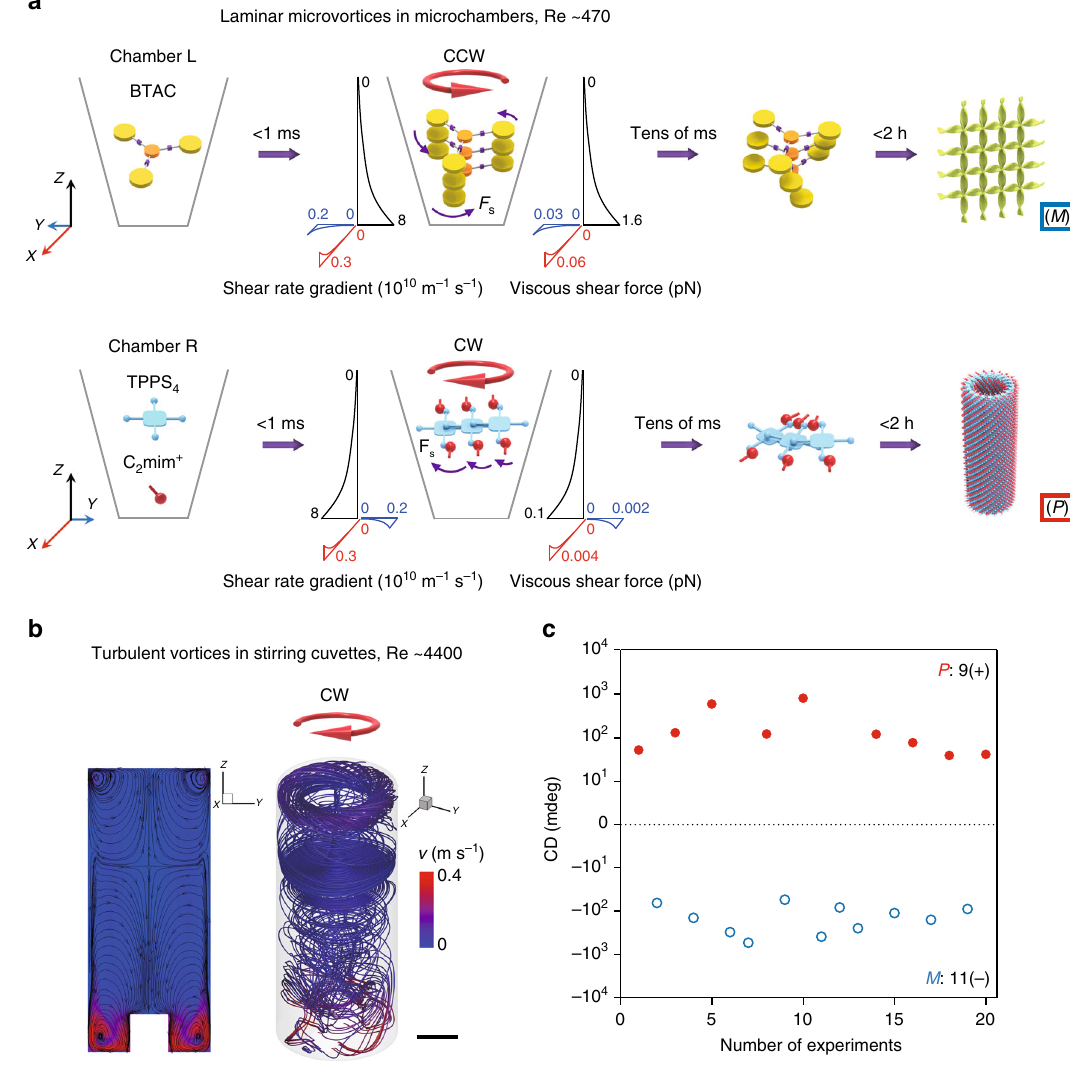
Fig. 5 Laminar chiral microvortices versus turbulent vortices in stirring cuvettes. a Schematic mechanism of laminar chiral microvortex-selected chirality of BTAC and TPPS 4 nuclei. The rapidly formed nuclei (<1 ms) are aligned in the laminar fl ow, and twisted by a shear force ( F s ) to give rise to an initial chiral bias dependent on the rotation sense of microvortices. These primary nuclei then serve as the templates for the subsequent growth into supramolecular assemblies with the prede fi ned chirality. Red, blue, and black axes refer to the spatial distributions of shear rate gradient and viscous shear force along the x , y , and z axes. b CFD simulation of chaotic fl ows generated by CW stirring at ~1000 rpm in cuvettes. Left: 2D representation of the fl ow direction (black streamlines) and velocity (color). Right: 3D streamlines display a snapshot of chaotic fl ows. The color bar indicates the magnitude of fl ow velocity. Scale bar, 5 mm. c CW stirring in cuvettes shows 9 positive CD signals ( P chirality, solid red circles) and 11 negative CD signals ( M chirality, void blue circles)